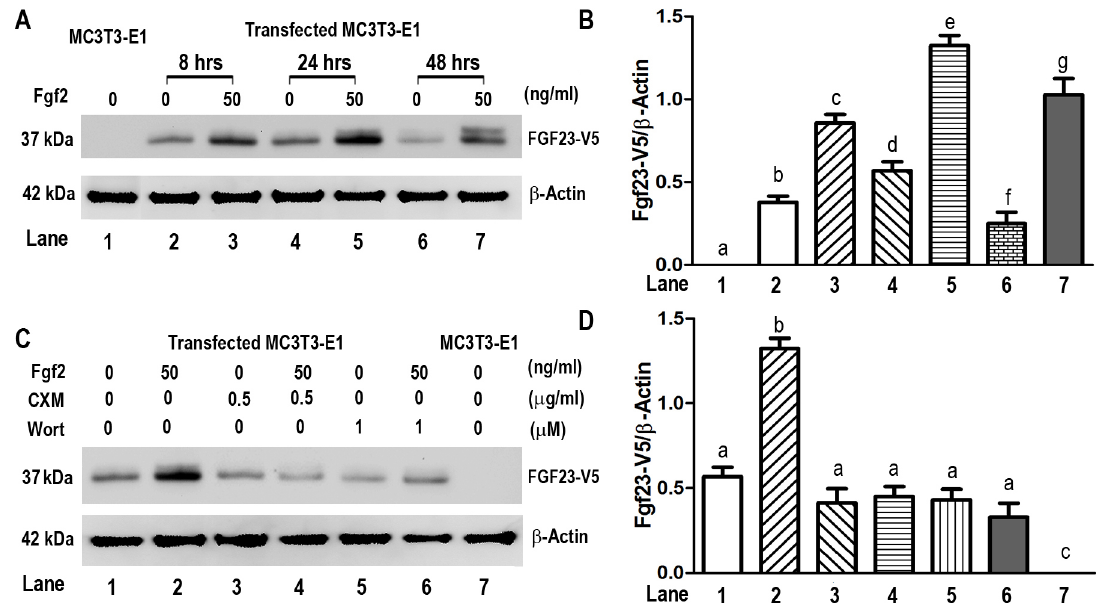
Figure 6. Translational control of human FGF23-V5 protein expression by FGF2 via FGFR1 signaling pathway. MC3T3-E1 cells were co- transfected with pcDNA3.1- FGFR1 expression plasmids and human pcDNA3.1-FGF23-V5-His expression plasmids and treated with different drugs as described in Material and Methods. (A and B) Time-dependent stimulation of human FGF23-V5 protein expression by recombinant FGF2 (50 ng/ml); (C and D) Effect of PI3K inhibitor Wortmannin (Wort) and protein synthesis inhibitor Cycloheximide (CXM) on FGF2-induced human FGF23-V5 protein expression. Both Wortmannin and Cycloheximide completely blocked FGF2-induced FGF23 protein increase. Data are expressed as the mean 6 S.D. from triple three independent experiments. Values sharing the same superscript in different groups are not significantly different at P ,